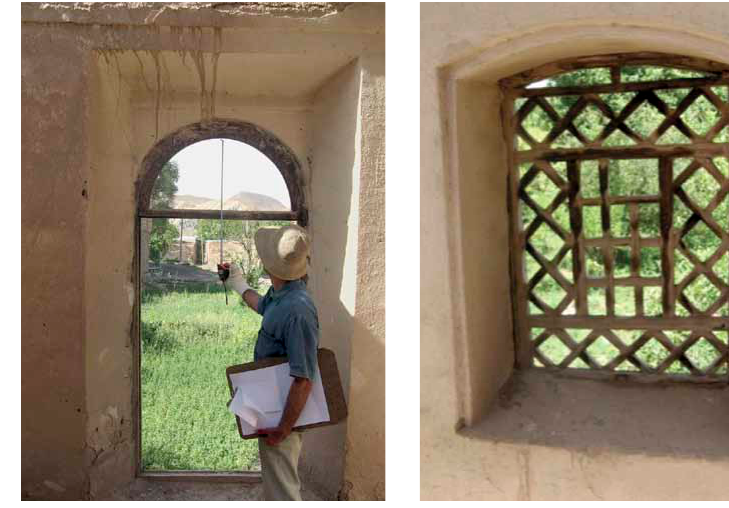
fig. 9. Some of windows types used in buildings group 1 & 2 (photo by